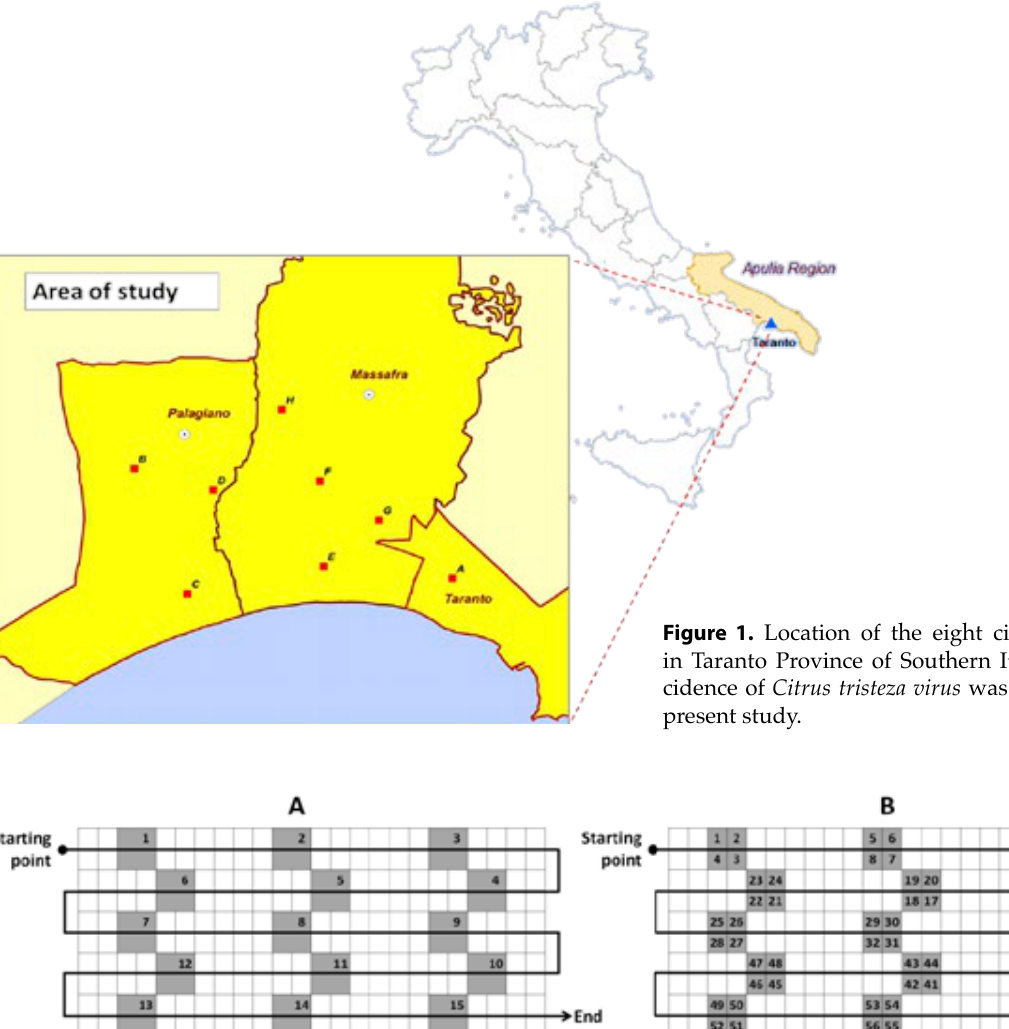
Figure 2. Representation of the sampling scheme by Hughes and Gottwald (1998): grouped samples of four trees each (grey squares) in HS method (A), and samples of individual trees (in grey squares) in the MAIB-S method (B). In both methods un-sampled trees are in white squares and the black arrows represent the sampling path through the grove from the same starting